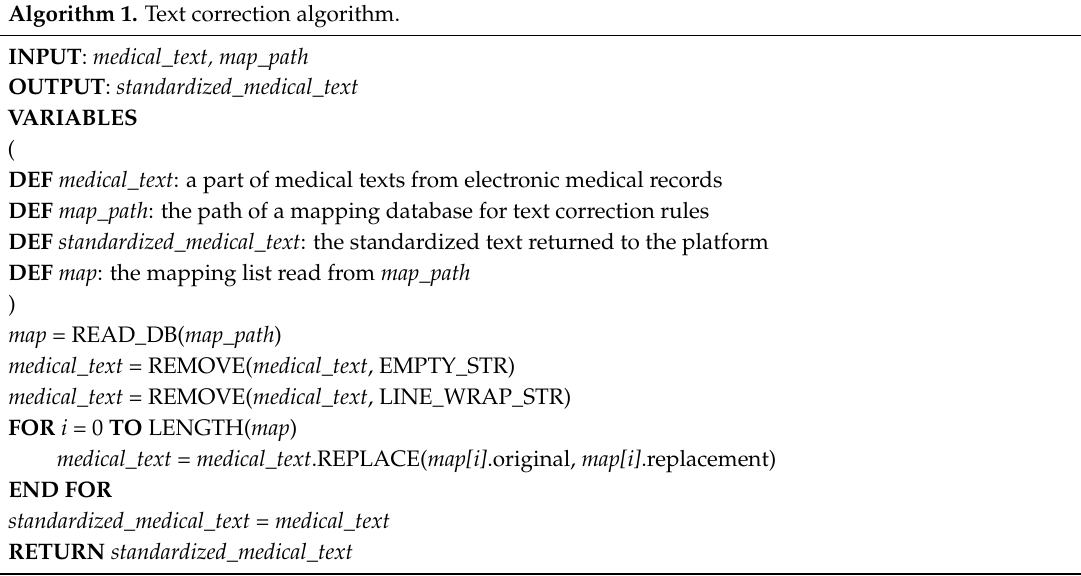
Algorithm 1. Text correction algorithm.